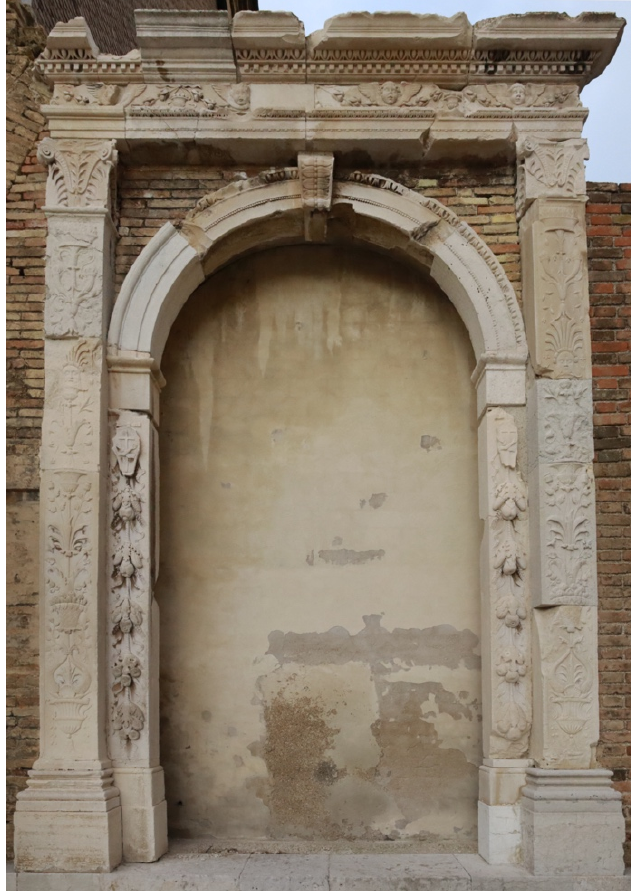
Figure 3. Stone frame of the Scottivoli altar. Ancona, San Francesco delle Scale. Author’s